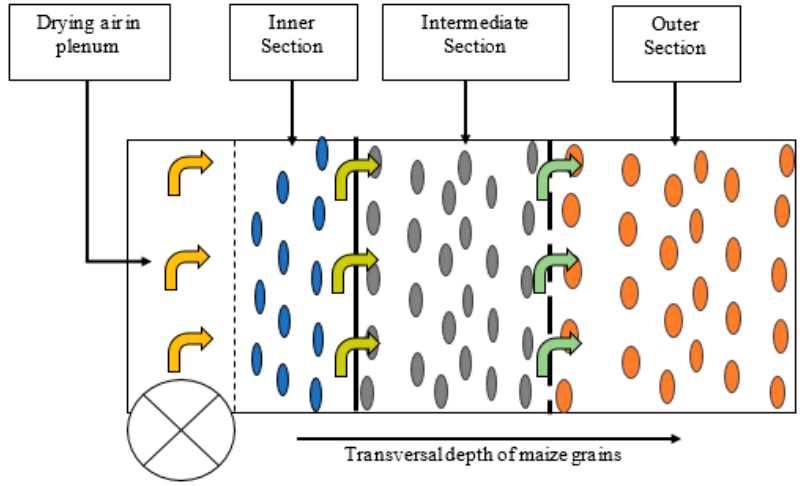
Figure 7. Moisture content variation with time at the inner and outer sections of the dryer.